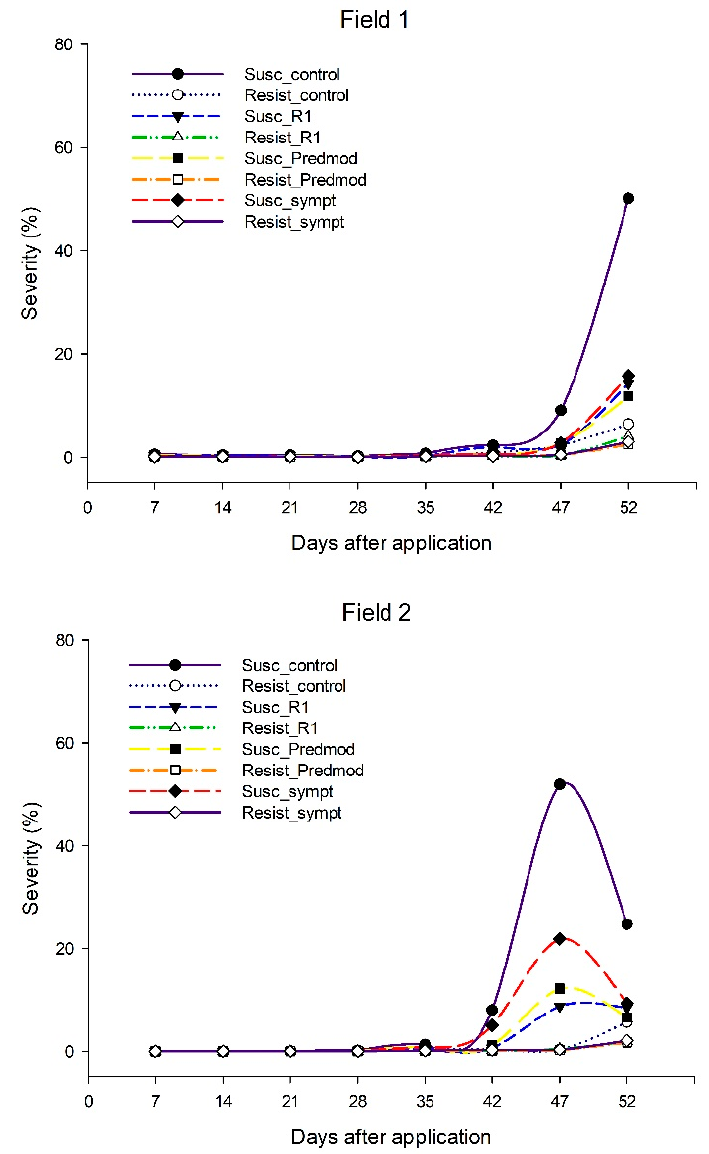
Figure 14. Soybean rust disease progress curve at Field 1 and Field 2 trial repetitions, according to the different soybean cultivars and application timings (treatments). Note: Susc_: susceptible soybean cultivar (DS6217); Resist_: partially resistant soybean cultivar (TMG7063). Control: without fungicide application; Calend: calendarized application (reproductive growth stage R1); Model: application timing based on the prediction model; Sympt: application timing based on the appearance of the first